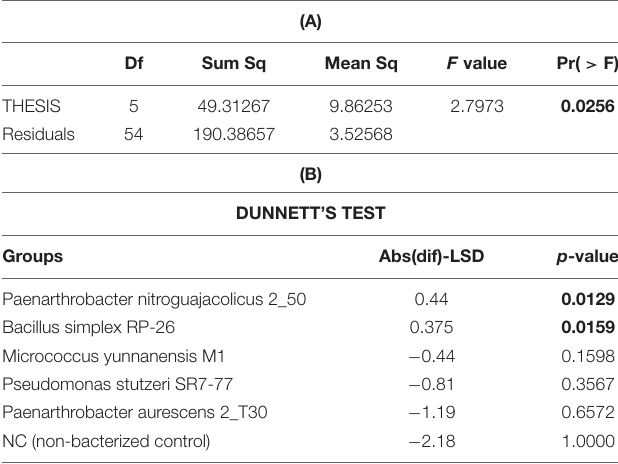
TABLE 3 | Comparison of the effect of PGP bacteria inoculation on WP of tomato plants under full irrigation